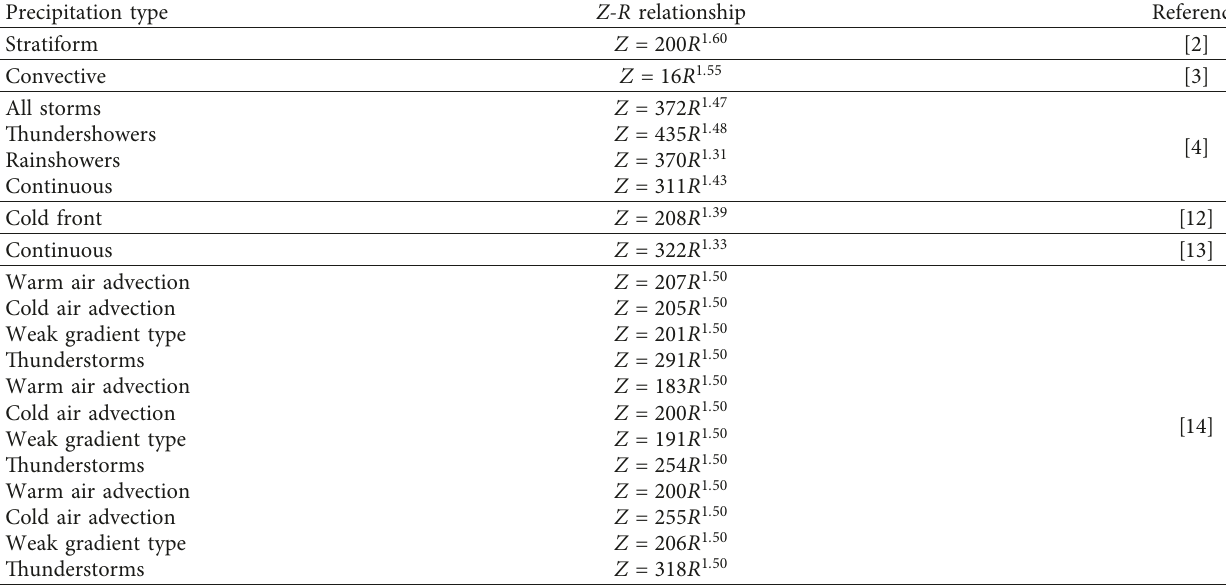
Table 1: Z - R relationships collected from past studies and